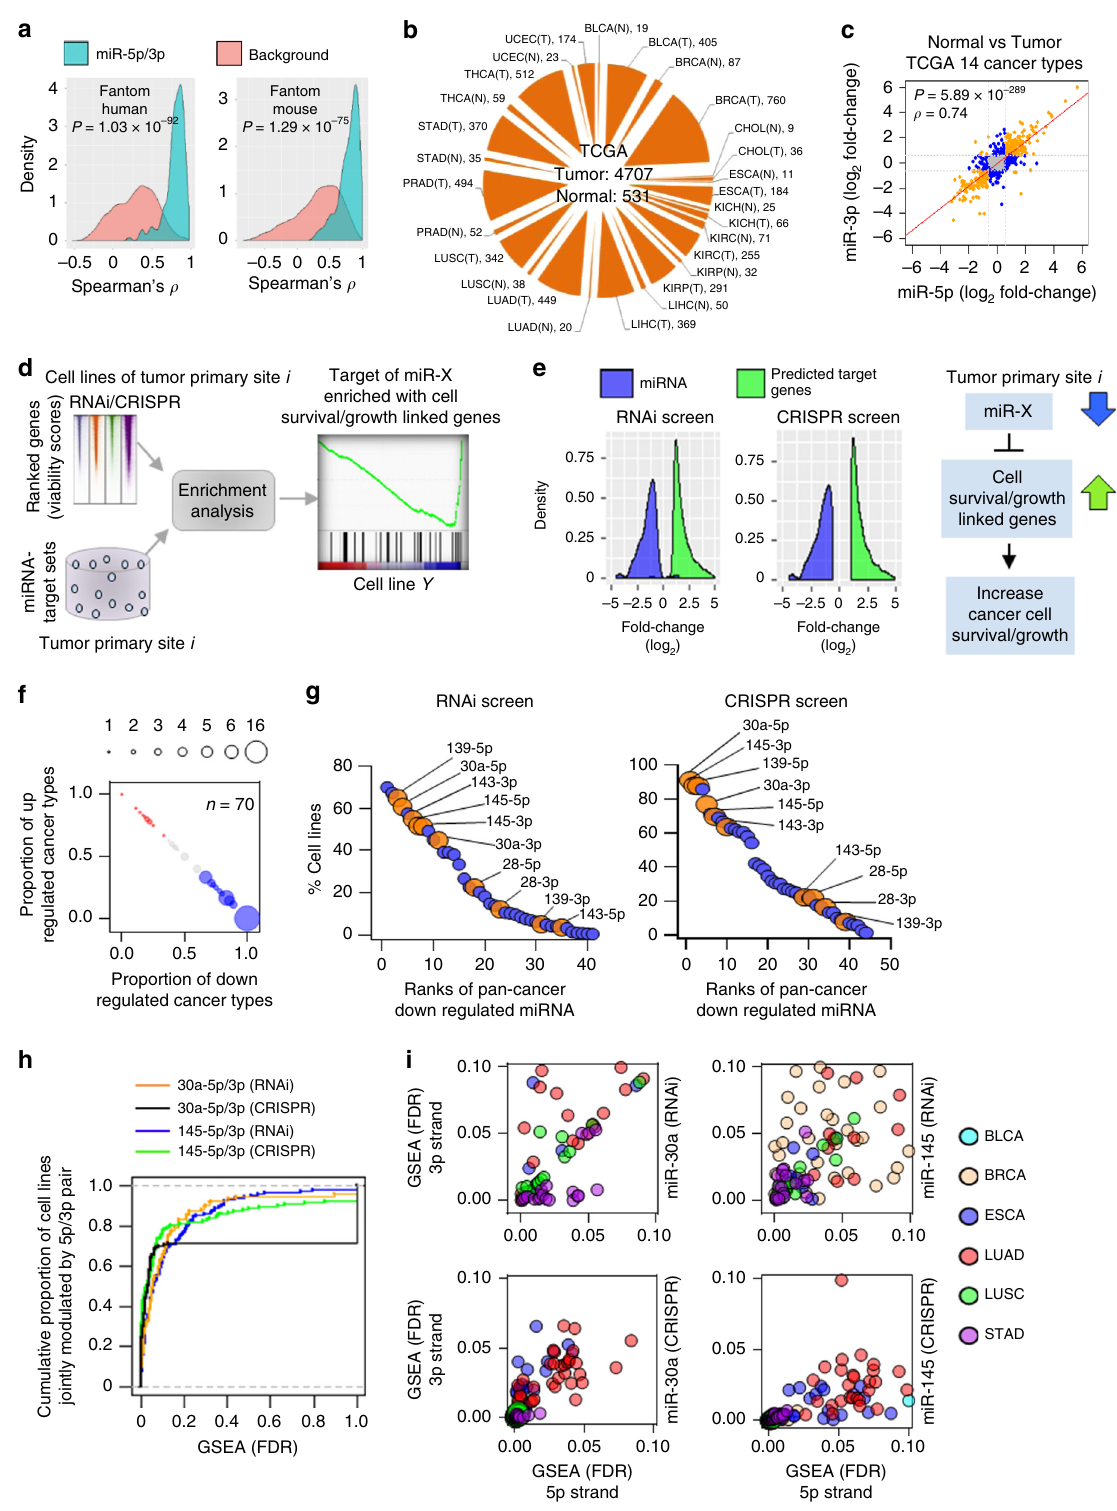
Ranks of pan-cancer down regulated